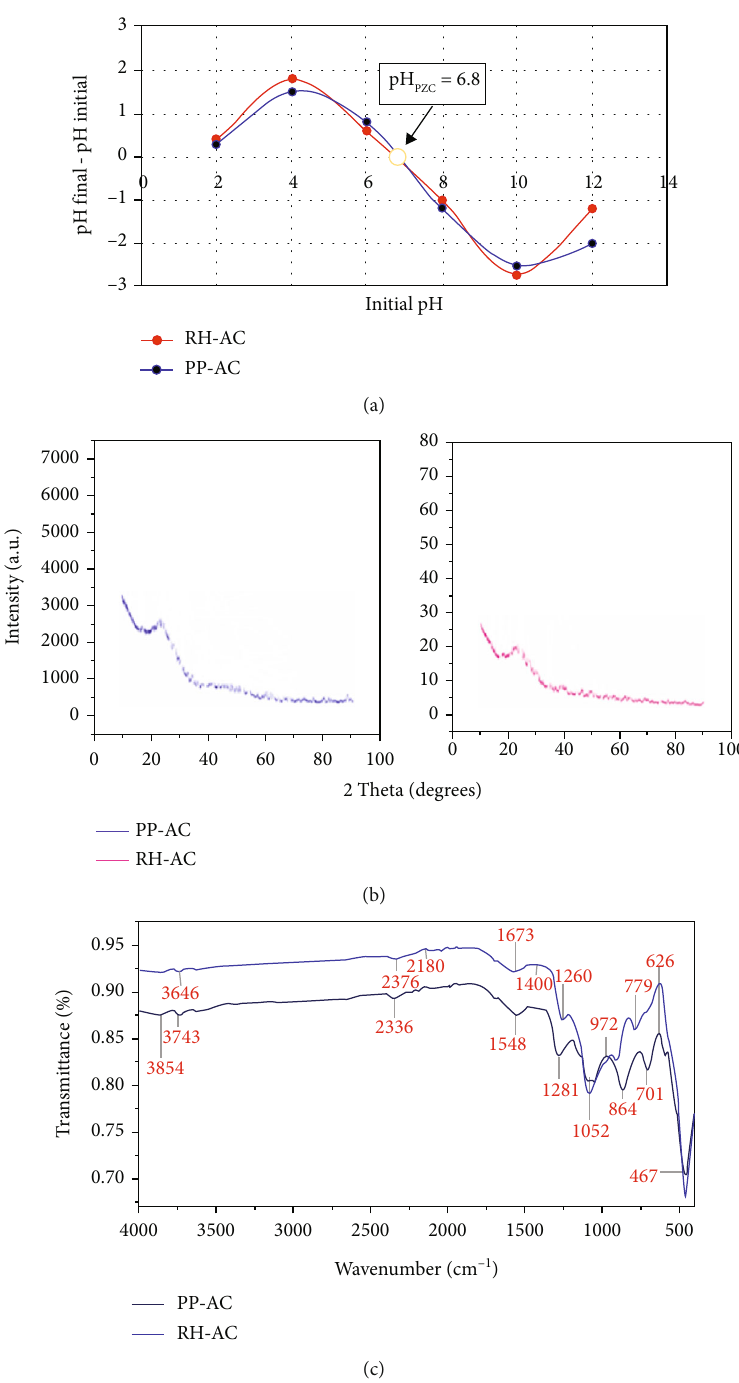
Figure 2: The (a) pHpzc for RH-AC and PP-AC, (b) X-ray chromatogram, and (c) FT-IR